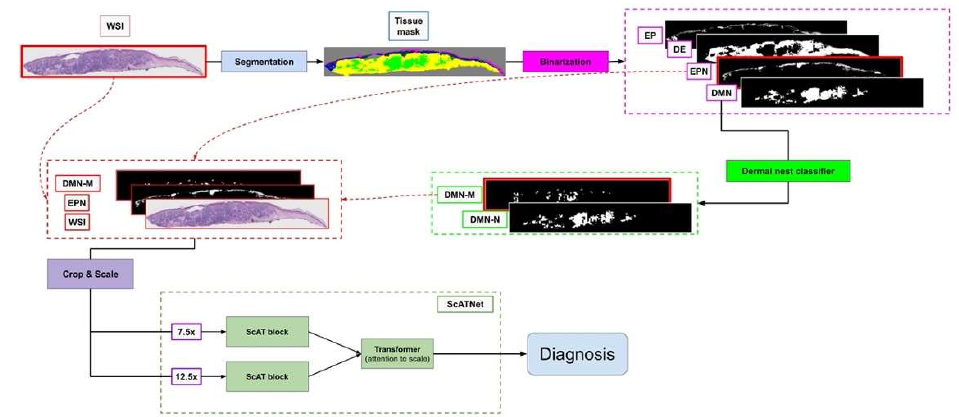
Figure 8. Overview of our diagnosis pipeline. The WSI goes to the segmentation pipeline to generate a tissue segmentation mask. Then, four clinically important tissue structures: epidermis (EP), dermis (DE), epidermal nest (EPN), and dermal nest (DMN) will be extracted into four corresponding binary masks. Extracted Dermal Nests will go through a dermal nests classification step to generate two sub-categories of melanoma dermal nest (DMN-M) and nevus dermal nest (DMN-N). Then, the selected tissue masks based on the experiment will be concatenated to the RGB channels of the WSI image. Each image will be cropped into smaller patches afterward. The patches go through the ScATNet pipeline that extracts patch embeddings, then, using contextualized patch-embedding and scale-aware embedding across available scales, chooses the diagnostic class of the case from mild and moderate dysplastic nevi (MMD), melanoma in situ and severely dysplastic nevi (MIS), invasive melanoma T1a (T1a) and melanoma invasive ≥ T1b (T1b). Note that the concatenated masks to the WSI (DMN-M and EPN) and ScATNet scales (7.5× and 12.5×) shown in this figure are just one example of our multiple experimental studies.